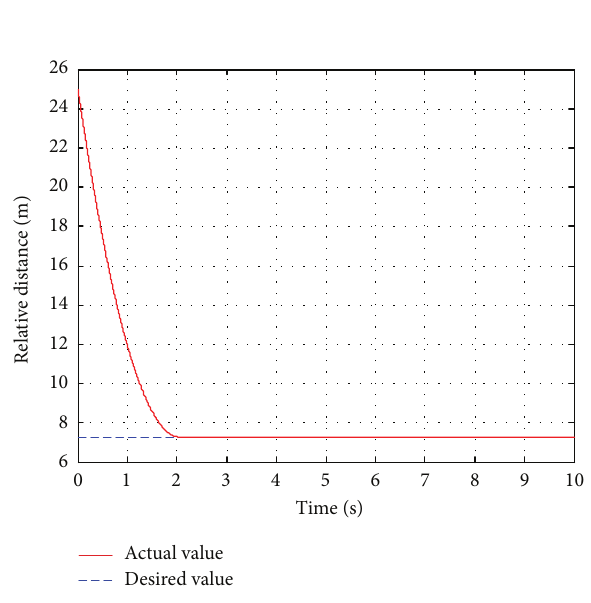
Figure 14: The relative